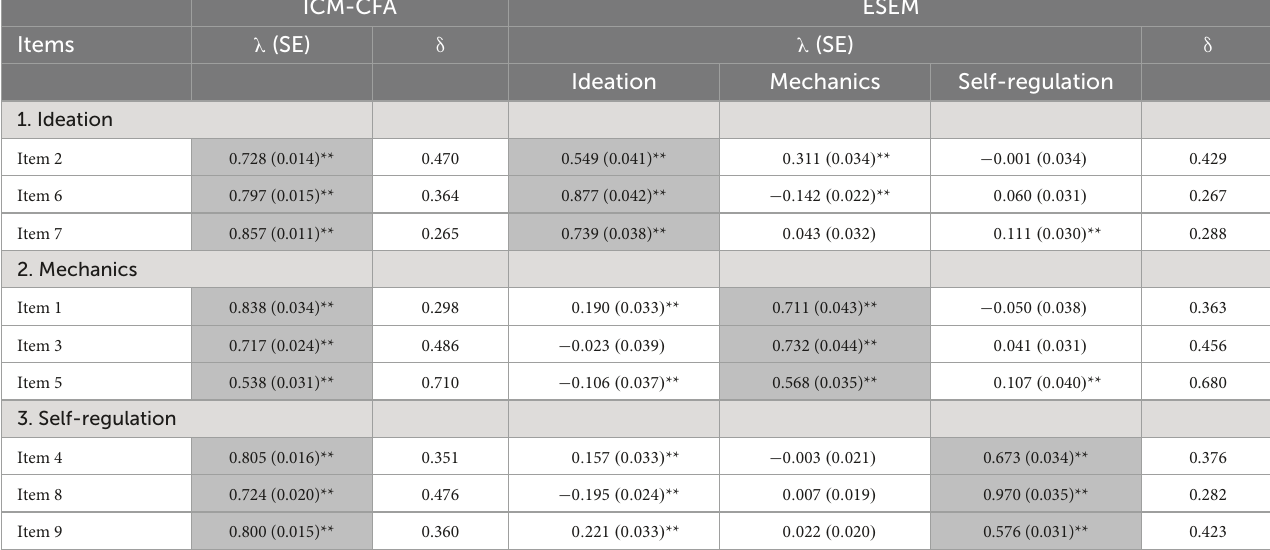
TABLE 4 Standardized factor loadings and residual variance for the CFA and